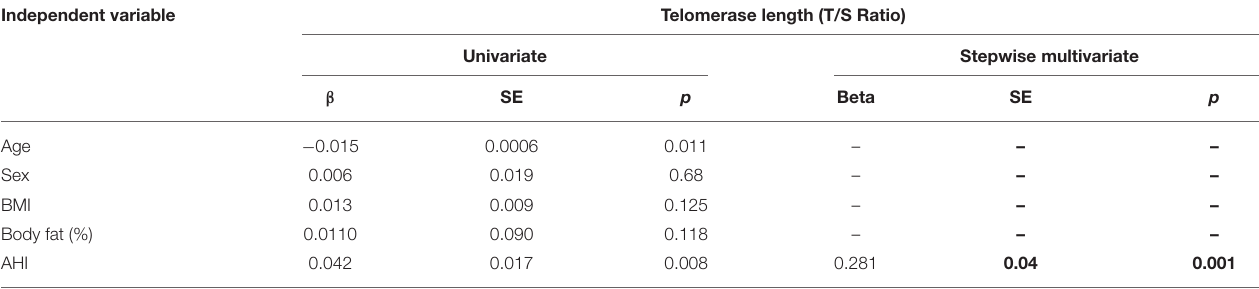
TABLE 3 | Univariate and multivariate analyses between AHI and LTL and covariates. Independent